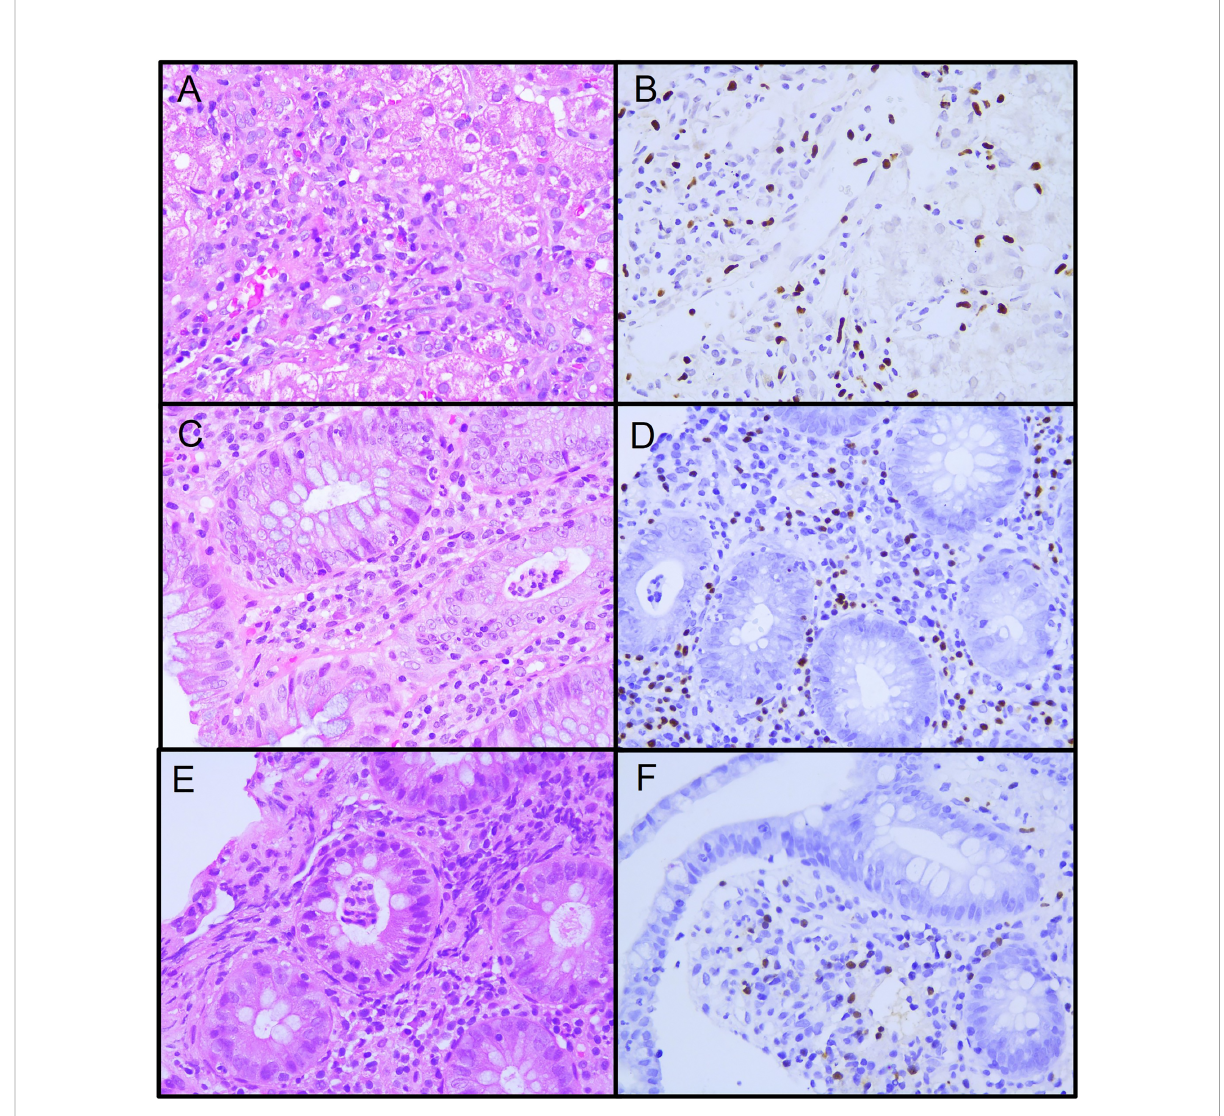
FIGURE 1 Histopathology specimens from patient 1. (A) Liver biopsy showing active diffuse lymphocytic in fl ammation. (B) Epstein-Barr encoding region (EBER) in situ hybridization in in fl ammatory lymphocytic in fi ltrate. (C) Colon biopsy showing intense lymphocytic and polymorphic in fl ammatory in fi ltrate at the lamina propria and neutrophilic crypt micro-abscesses. (D) EBER positive in in fl ammatory lymphocytic in fi ltrate in the lamina propria and crypta. (E) Ileum biopsy showing moderate lymphocytic and polymorphic in fl ammatory in fi ltrate at the lamina propria and neutrophilic crypt microabscesses. (F) EBER positive in in fl ammatory lymphocytic in fi ltrate in the lamina